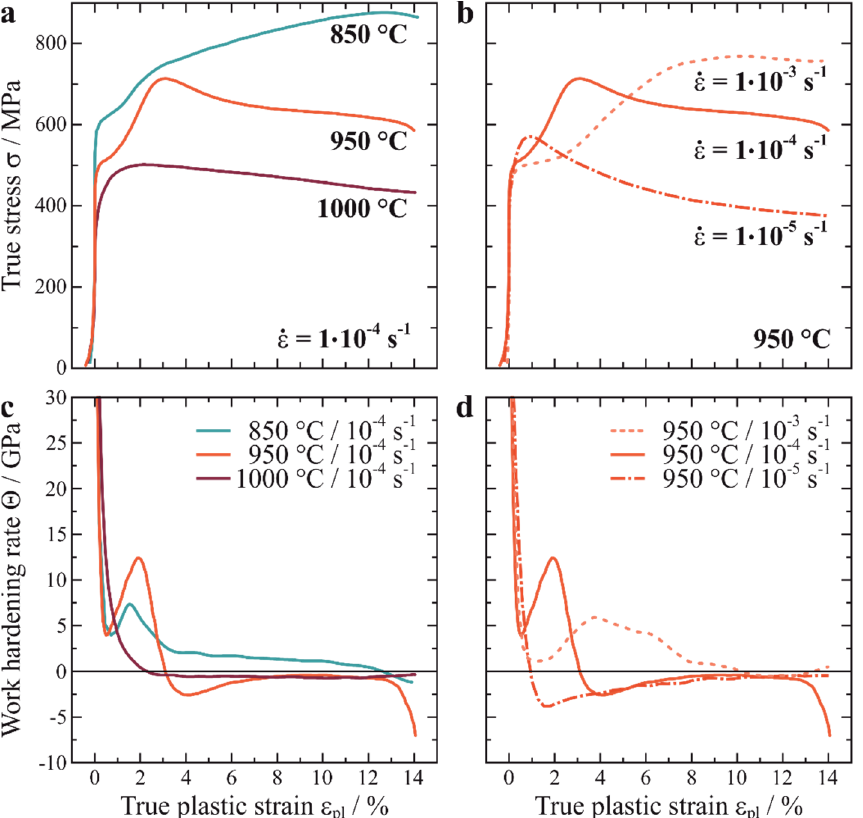
Figure 1. Stress ‐ strain curves of alloy VF60 ( a ) at different temperatures using a strain ‐ rate of 1 ⋅ 10 − 4 Figure 1. Stress-strain curves of alloy VF60 ( a ) at different temperatures using a strain-rate of s − 1 , ( b ) at 950 °C using different strain ‐ rates, and ( c ) and ( d ) the corresponding work hardening rate 1 · 10 − 4 s − 1 , ( b ) at 950 ◦ C using different strain-rates, and ( c , d ) the corresponding work hardening curves of ( a ) and ( b ). rate curves of ( a , b